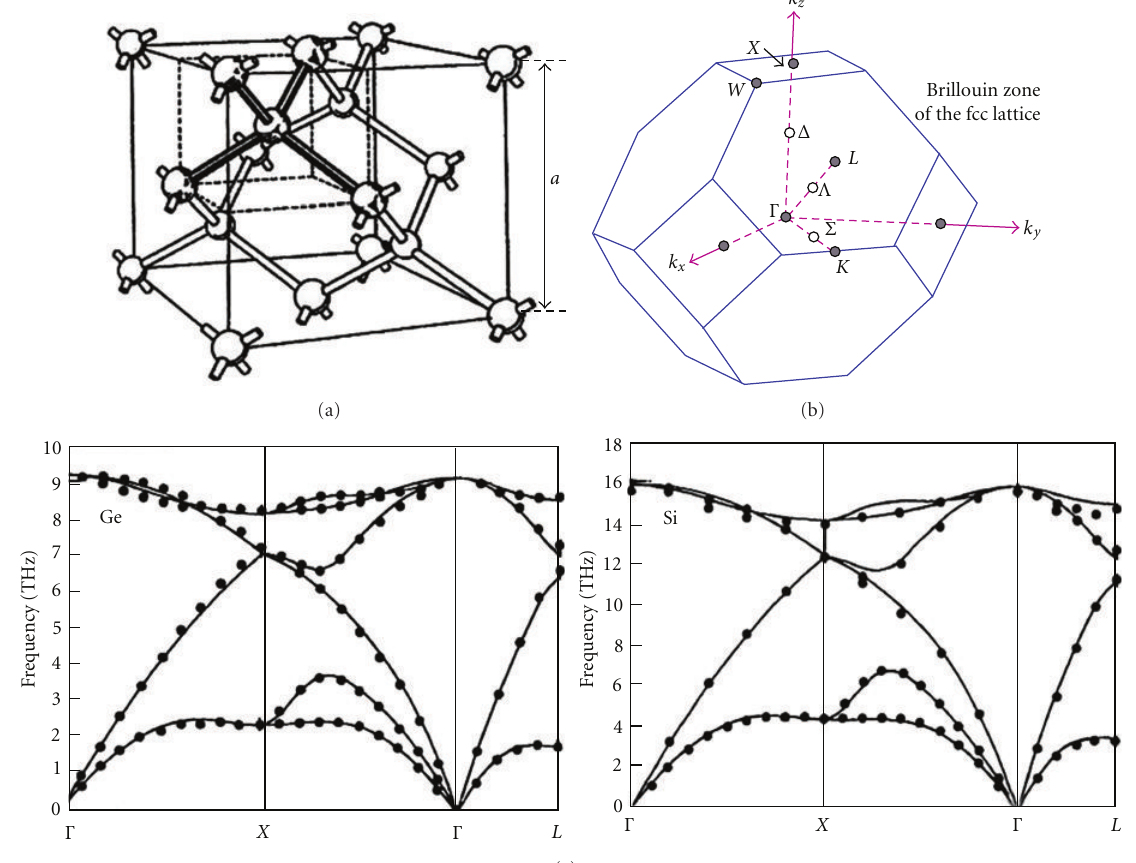
Figure 2: (a) Conventional cubic unit cell for the diamond crystal structure (F4 1 /d32/m). Each atom is tetrahedrally bonded to four nearest neighbors. The lattice parameter of the conventional unit cell containing four atoms, a = 0 . 5431 ´˚A (Si) and a = 0 . 5658 ´˚A (Ge), (b) Brillouin zone for the face-centered space lattice showing the positions of several high-symmetry axes and points [18, 19]. (c) Phonon dispersion curves of Ge [20] (left) and Si [20] (right) along high-symmetry directions. The dots are neutron scattering data [19, 21, 22], and the solid lines are calculations using up to the sixth nearest neighbor interactions in a Born-von K´arm´an force constant model [20]. The primitive cell contains two atoms; therefore, three optical branches (2TO and 1LO) and three acoustic branches (2TO and 1LO) are observed. These branches are degenerate at the Γ point.